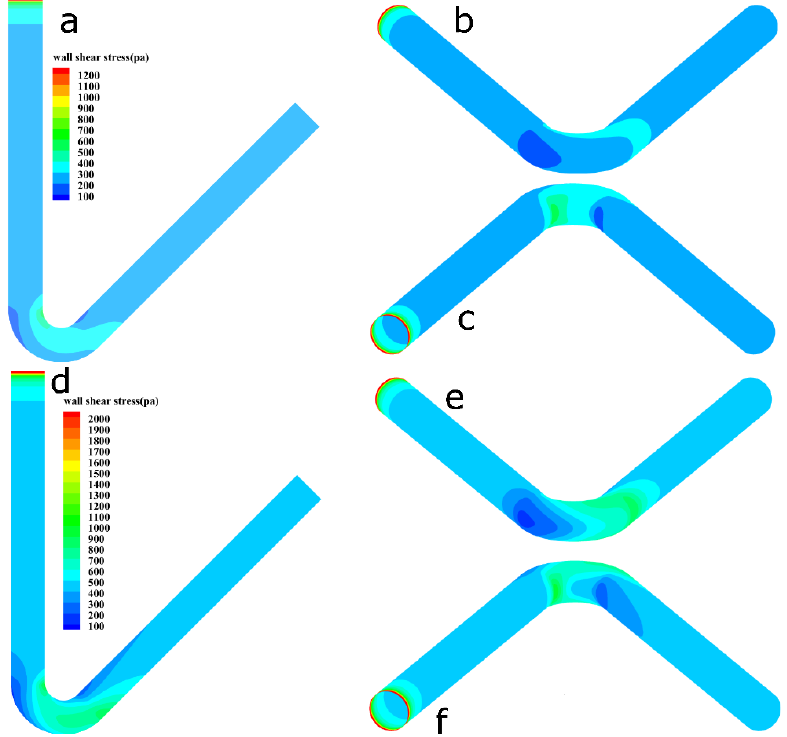
Figure 9. ( a ) Top view of the distribution of the magnitude of the wall shear stress on the 45° channel at the conveying rate of 2.85 cm 3 /s. ( b ) The distribution viewed from the outer bend in the same case as ( a ). ( c ) The distribution viewed from the inner bend in the same case as ( a ). ( d ) Top view of the distribution of the magnitude of the wall shear stress on the 45° channel at the conveying rate of 4.75 cm 3 /s. ( e ) The distribution viewed from the outer bend in the same case as ( d ). ( f ) The distribution viewed from the outer bend in the same case as ( d ).